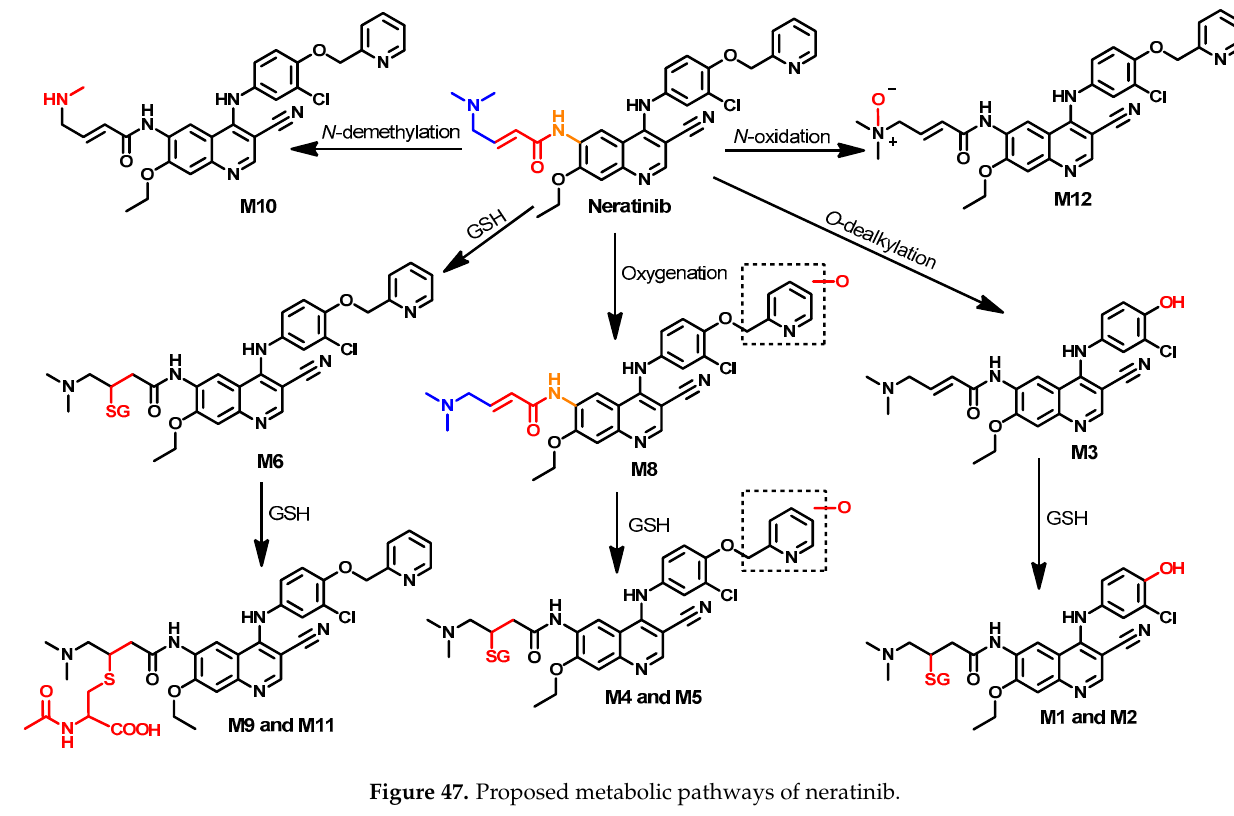
Figure 47. Proposed metabolic pathways of neratinib.